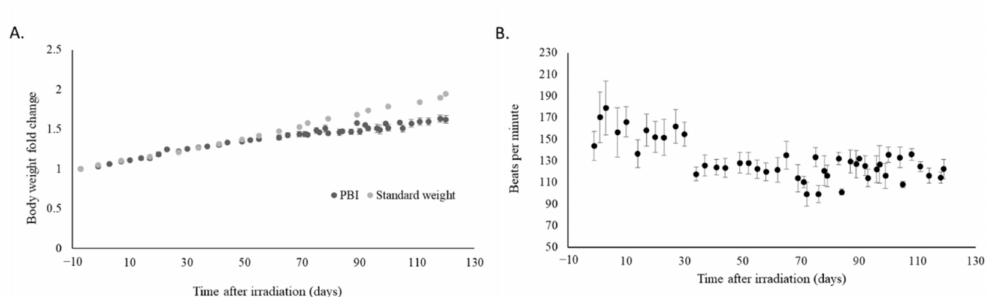
Figure 2. Evaluation of body weight and heart rate in irradiated animals. ( A ) Body weight and ( B ) heart rate were measured throughout the study in minipigs exposed to PBI; heart rates were reported as averages +/ − sem ( B ). Body weight measurements were compared to values from reference age-matched, non-irradiated animals provided by the vendor and plotted as a control (standard